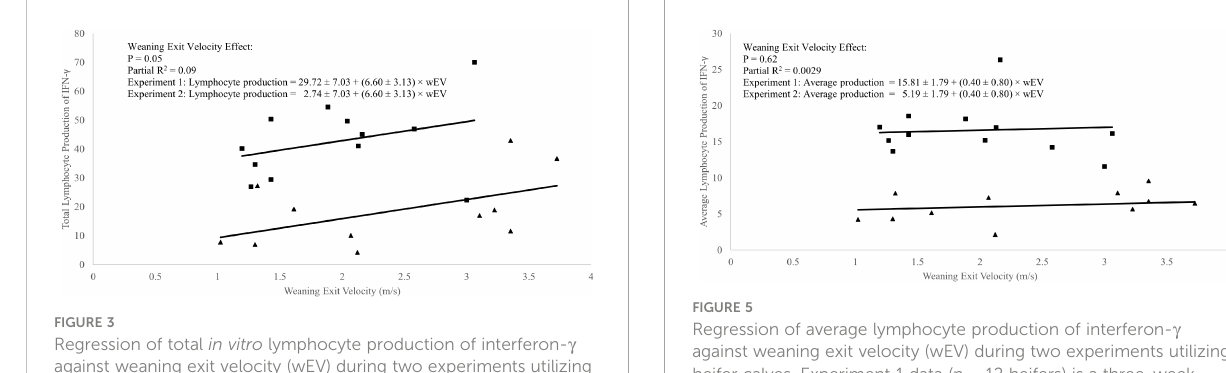
FIGURE 5 Regression of average lymphocyte production of interferon- g against weaning exit velocity (wEV) during two experiments utilizing heifer calves. Experiment 1 data (n = 12 heifers) is a three-week baseline average of the average lymphocyte IFN- g production beginning one week after calves were placed in barn. Experiment 2 (n = 11 heifers) data were from a single collection on the day calves were placed in the barn. One data point was removed from experiment 2 data due to an insuf fi cient number of cells harvested from the sample. PBMCs were isolated from whole blood collected weekly via jugular venipuncture, treated with transport inhibitor brefeldin A, and stimulated with phorbol 12-myristate 13-acetate + ionomycin. Experiment 1 ( ■ ). Experiment 2 ( ▲ ). Experiment was a signi fi cant source of variation (P < 0.01) but there was no interaction between experiment and wEV (P =